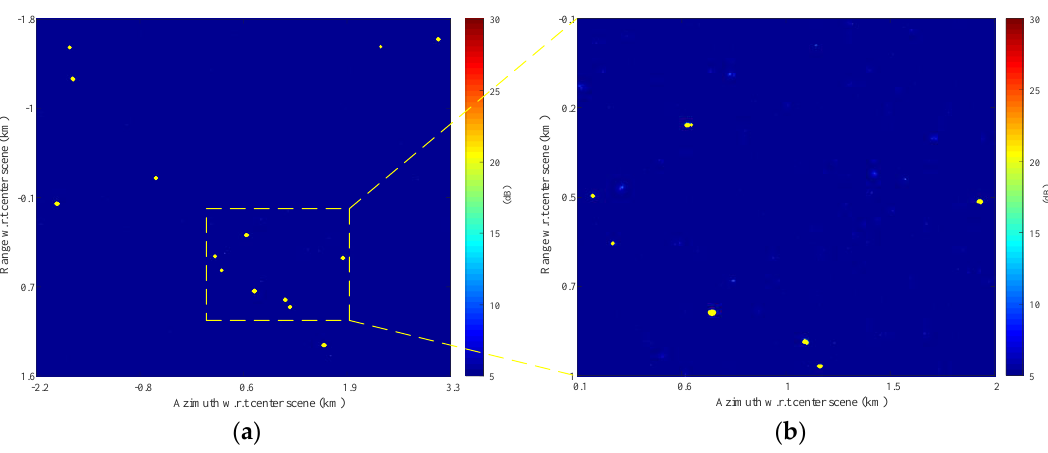
Figure 10. CFAR Detection result with the detected pixels marked by yellow dots: ( a ) full scene; and ( b ) magnified part of ( a ).